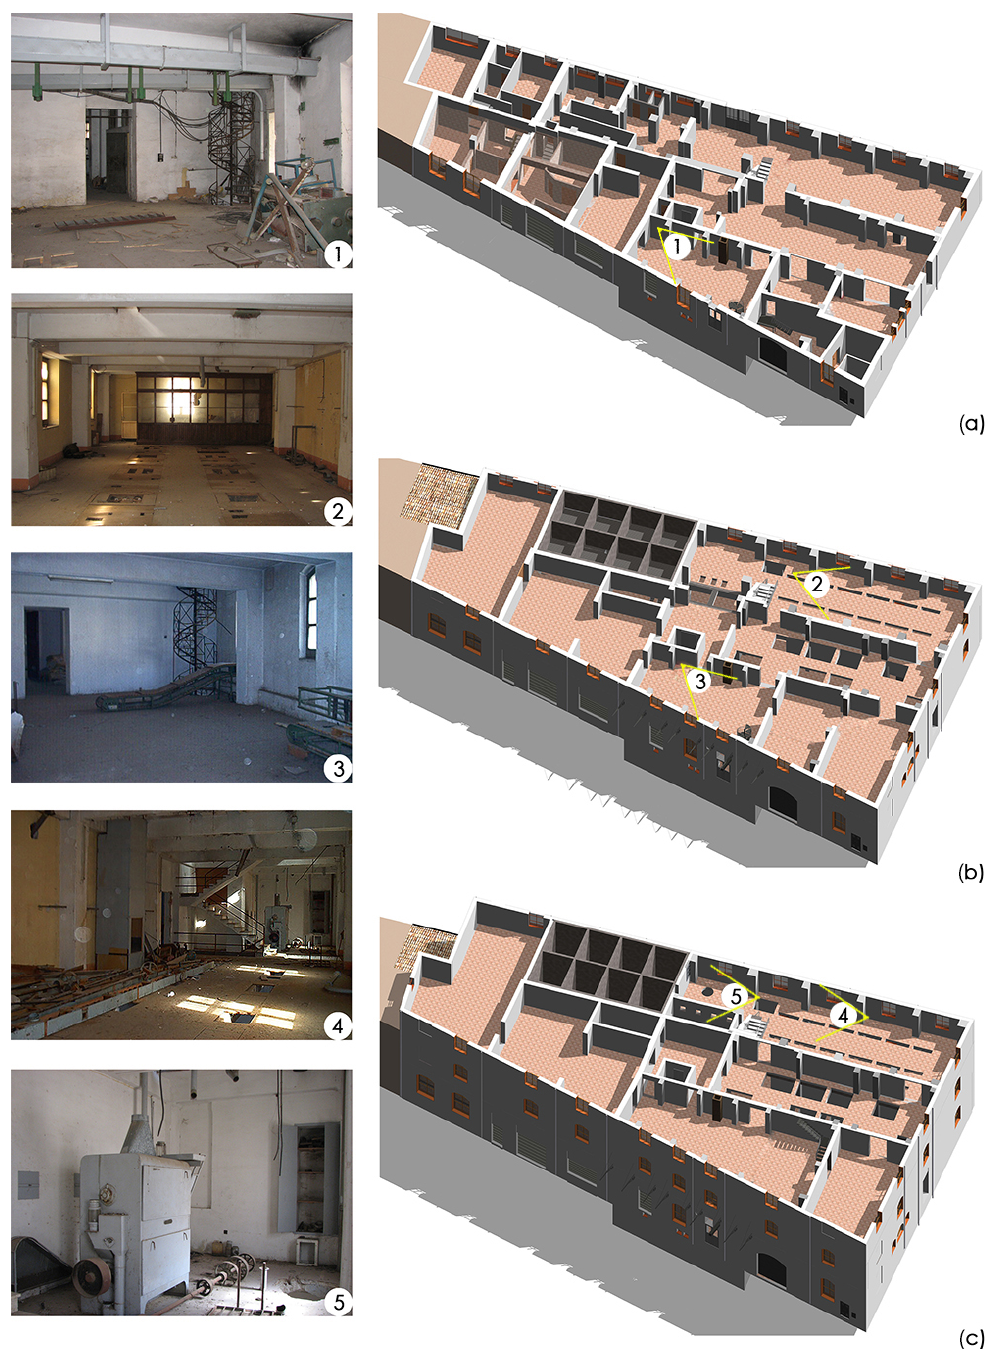
Figure 9. ( a ) First floor; ( b ) Second floor; ( c ) Third